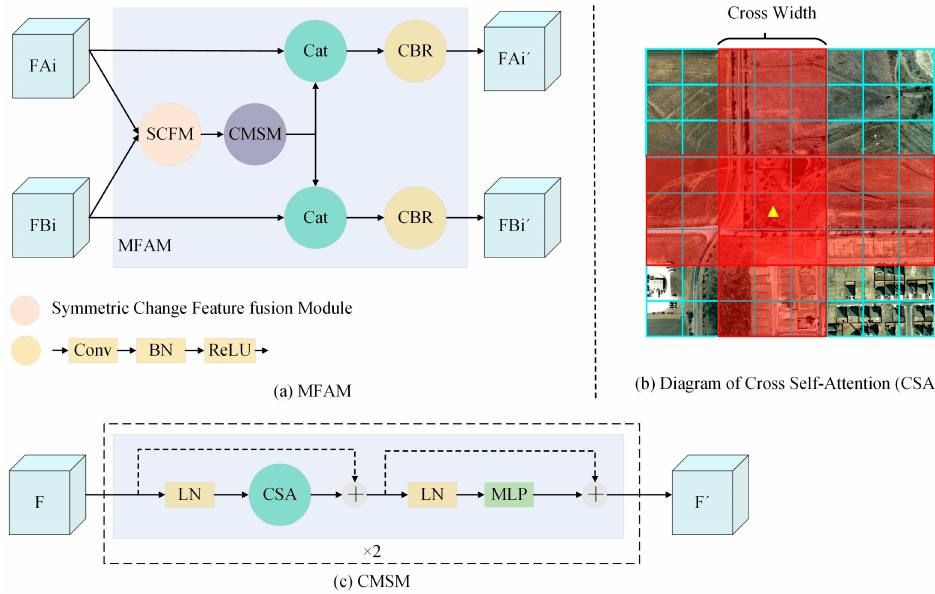
Figure 3. ( a ) Mutual Feature-Aware Module; ( b ) Diagram of Cross Self-Attention (CSA); ( c ) Cross Multi-headed Self-attention